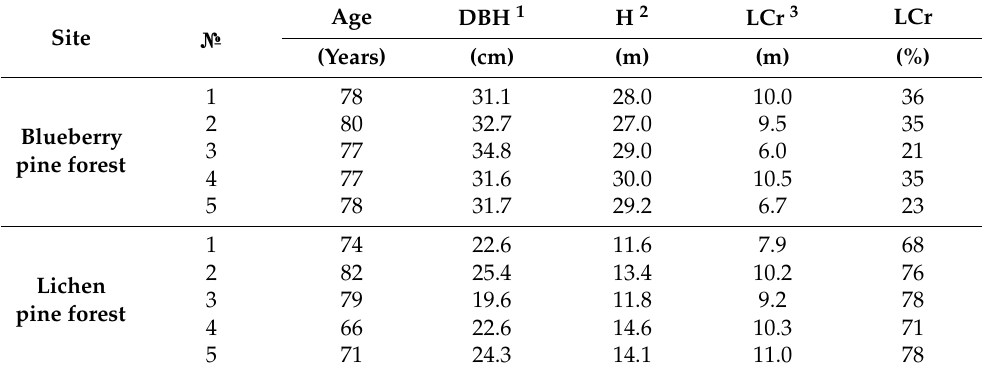
Table 4. Information of randomly selected stems (for model